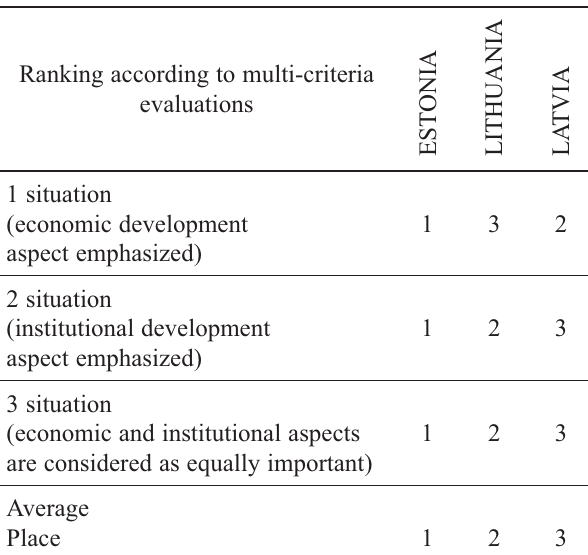
Ranking according to multi-criteria